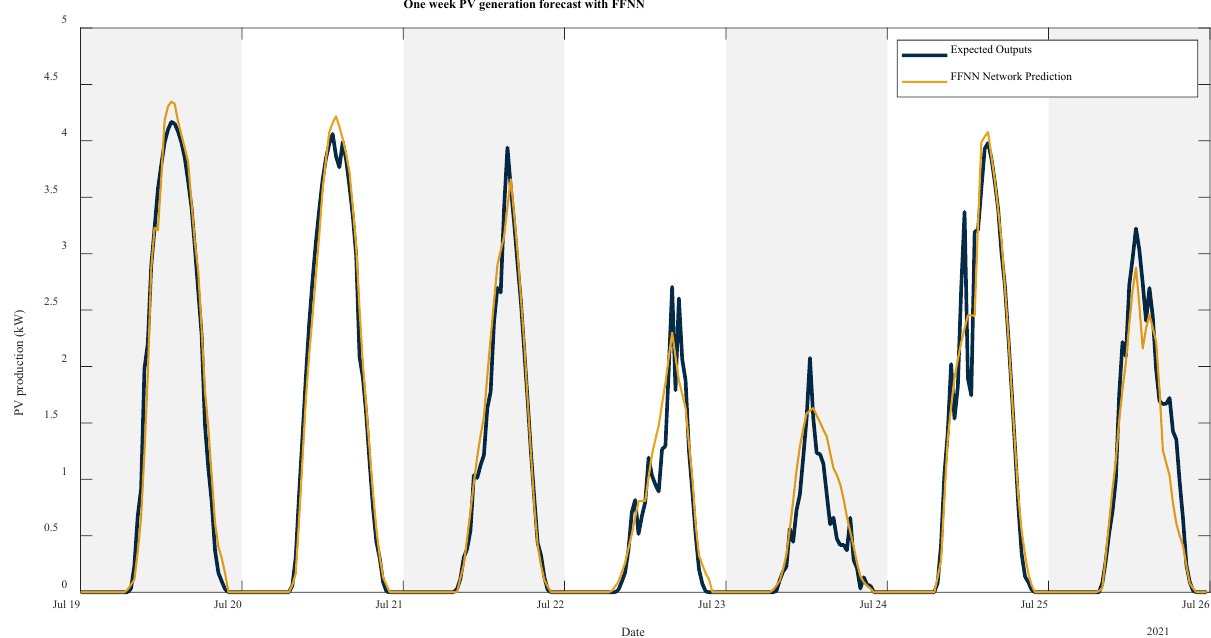
Figure 11. Forecast of PV generation for a week of July with FFNN model.